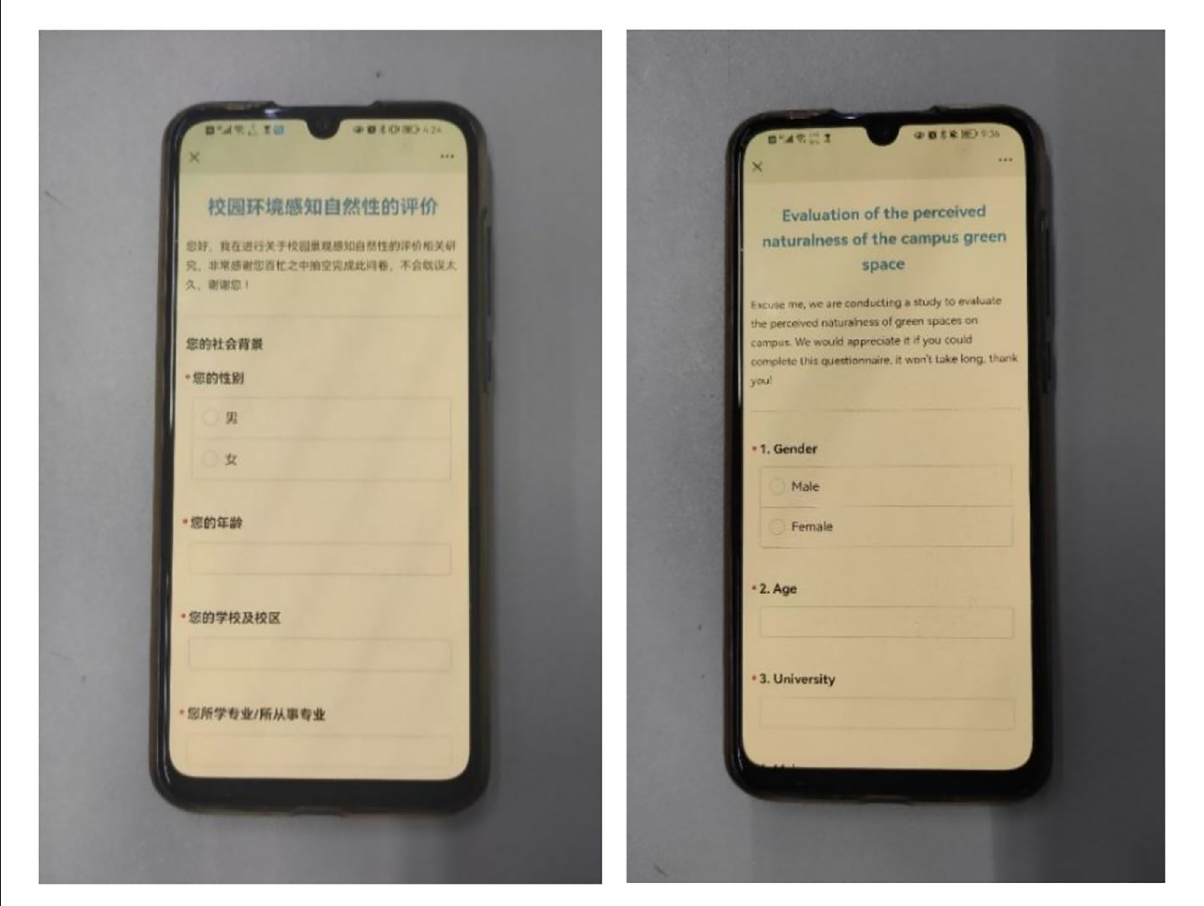
FIGURE4 Questionnaire form sample in Chinese and